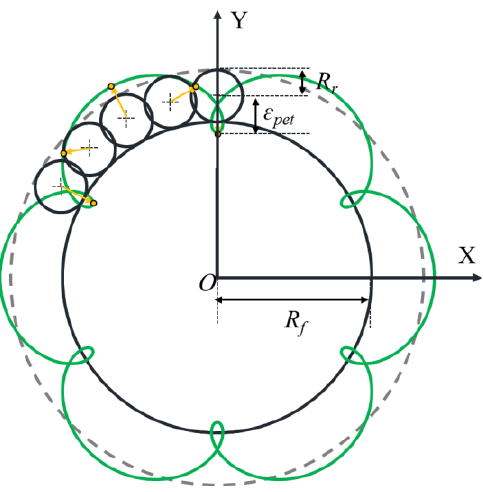
Figure 3. Prolate epitrochoid (PET) curve.